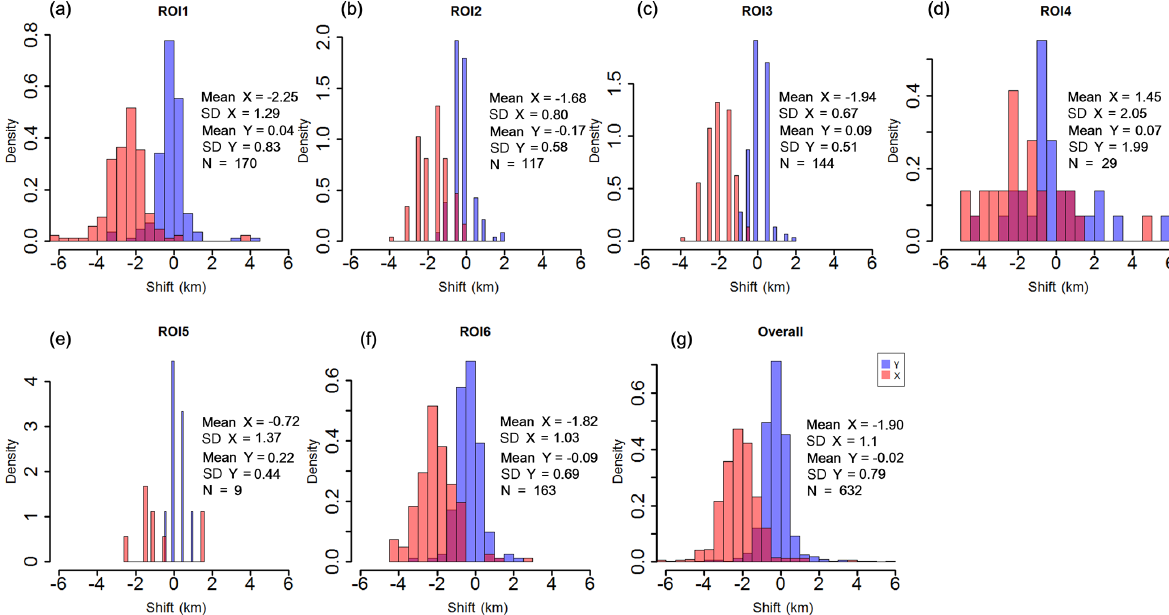
Figure 6. The distribution of shifts in the across-track ( x , represented by the red histogram) and along-track ( y , denoted as the blue histogram) directions over different regions for the MetOp-A scene. The unit of the shift is kilometers. For histograms, density instead of frequency is labeled in the